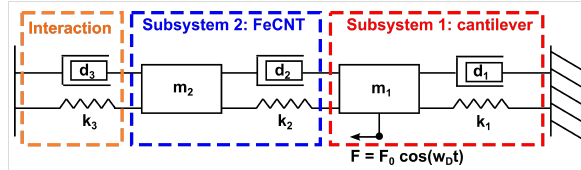
Figure 1: Simple model for two coupled harmonic oscillators, each represented by a mass ( m 1 , m 2 ), a sping ( k 1 , k 2 ) and a damping ele- ment ( d 1 , d 2 ). The system is excited to oscillations by a periodic force with the driving angular frequency ω D = 2 π f D applied to the first subsystem. Interactions between the system and external influences are modeled by an additional spring k 3 and the damping element d 3 .